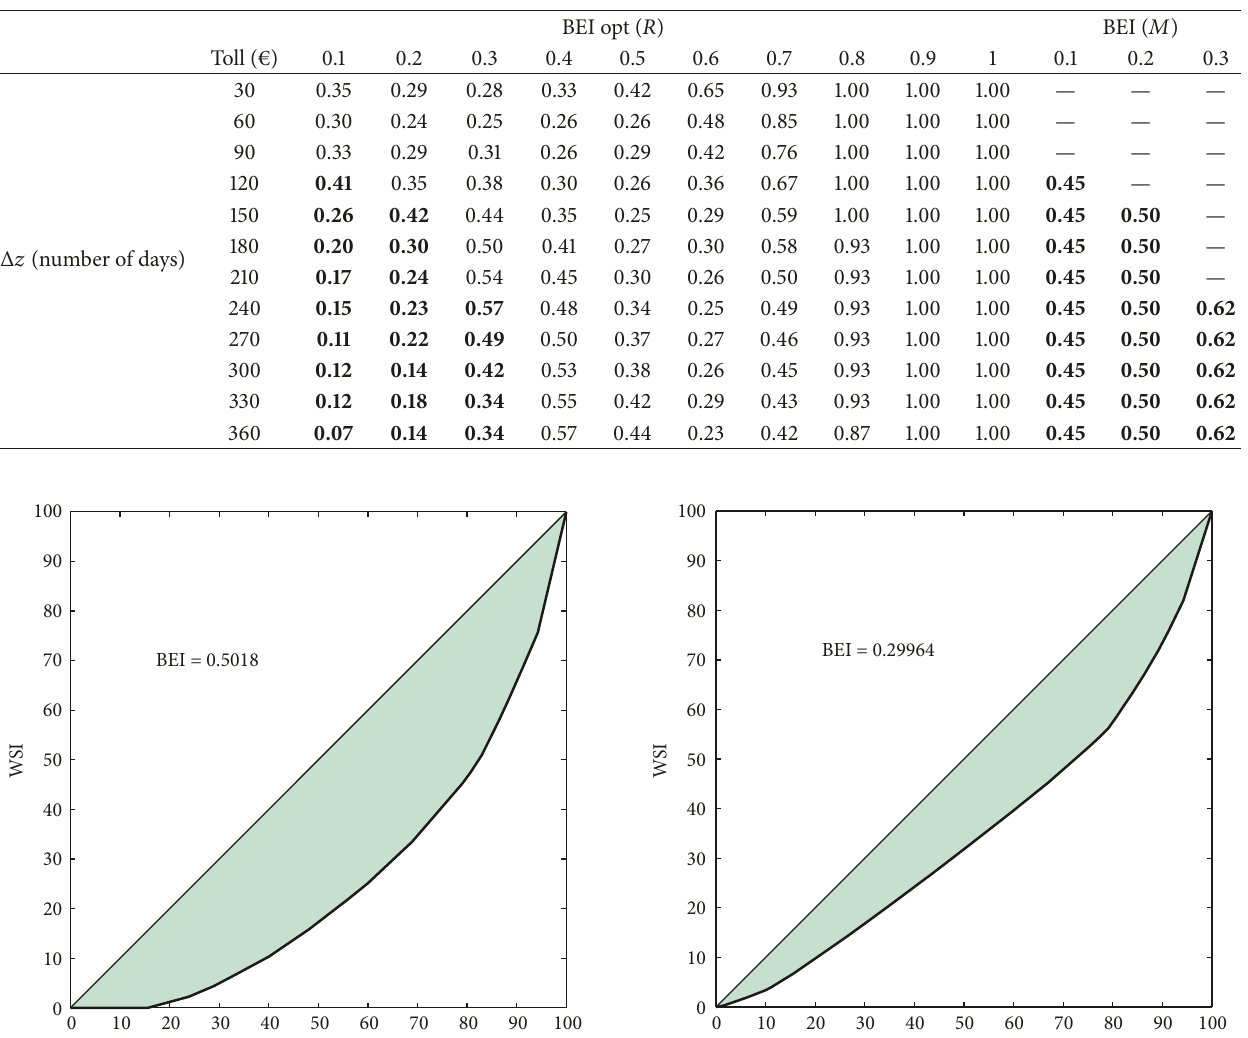
Table 4: BEI values according to the selected amount of the toll and number of days.